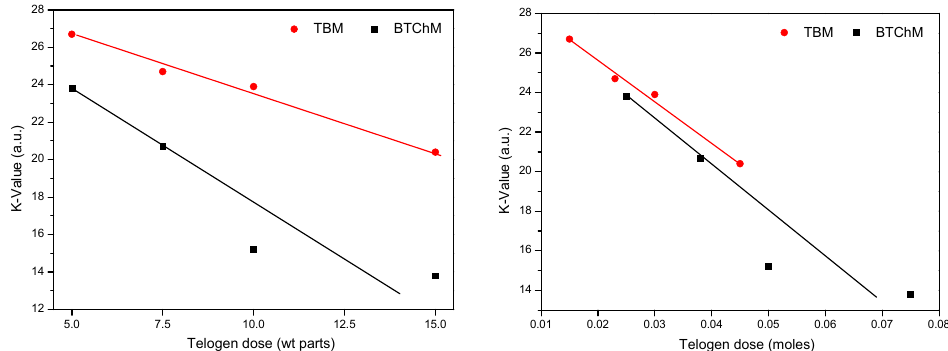
Figure 2. K-values of multifunctional acrylic telomer solutions in relation to the type and dose (by weight or moles) of the telogens.